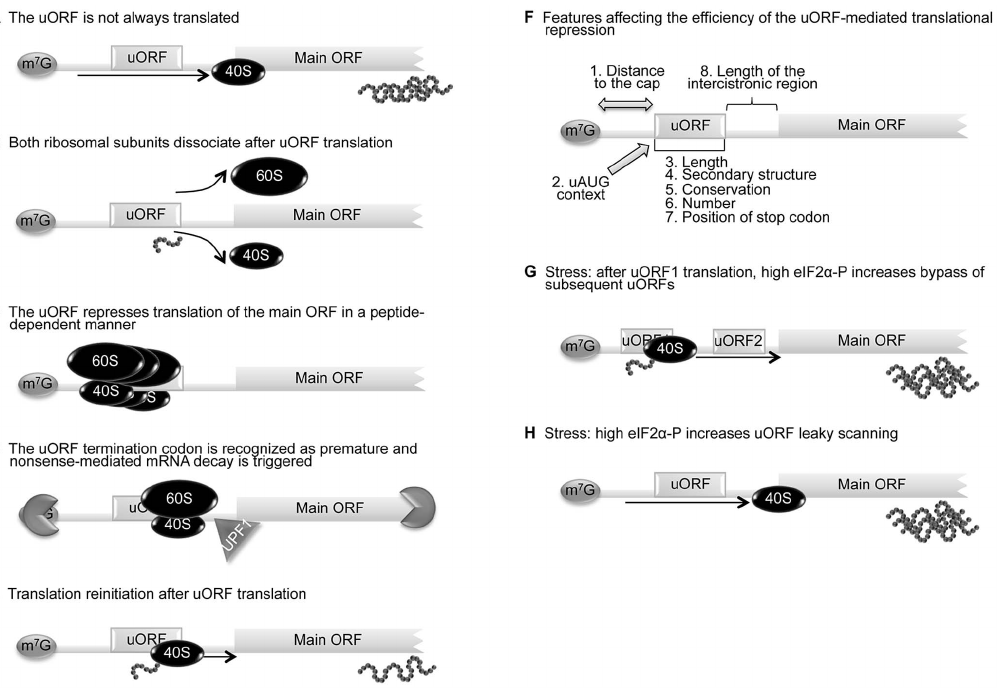
Figure 1. uORF-mediated translational control can occur through different mechanisms. ( A ) The leaky scanning mechanism is dependent on the efficiency of uAUG recognition; sometimes the ribosome can translate the uORF, but other times the scanning machinery bypasses the uAUG, recognizing the downstream AUG and translating the main ORF. ( B ) When a scanning ribosome recognizes and translates a functional uORF, there is synthesis of a small peptide; if translation termination of the uORF is efficient, both 60S and 40S ribosomal subunits might dissociate from the transcript and the main ORF is not translated. ( C ) A uORF can repress translation of the main ORF in a peptide-dependent manner; in this case, the uORF-encoded peptide interacts with the translating machinery and promotes ribosome blockage. ( D ) The termination codon of a uORF can be recognized as premature and nonsense-mediated mRNA decay (NMD) is triggered through a mechanism involving the UPF1 protein and ribonucleases. ( E ) After translation termination of the uORF, the 40S ribosomal subunit can remain associated with the transcript, resume scanning, and recognize the downstream main AUG—a mechanism designated as translation reinitiation. ( F ) The impact that the uORFs can have on translation depends on (i) distance between the 5 9 cap (m 7 G) and the uORF (distance to the cap), (ii) context in which the uORF AUG is located (AUG context), (iii) length of the uORF, (iv) number of uORFs per transcript, (v) secondary structure of the uORF, (vi) conservation among species, (vii) length of the intercistronic sequence(s), and (viii) position of the uORF termination codon, upstream or downstream of the main initiation codon (length, number, secondary structure, conservation, position of stop codon). The increase of translational repression exerted by a uORF correlates with increasing distance between the m 7 G and the uORF, increasing length of the uORF and intercistronic sequence, a higher number of uORFs, and a stronger uAUG Kozak context. ( G ) In response to stress conditions, the presence of more than one uORF in a transcript can promote an increase in translation efficiency of the main ORF; the reinitiation after translation of the uORF1 is less efficient since there is less ternary complex available. Consequently, reinitiation will take more time/distance to occur and the ternary complex will only be available by the time the 40S ribosomal subunit has already bypassed the subsequent uORFs, augmenting the recognition of the main AUG. ( H ) In response to stress conditions, the presence of one uORF in a transcript can promote an increase of the corresponding protein levels; the higher levels of phosphorylated eIF2 a contribute to increase leaky scanning of the uORF and translation of the main ORF is